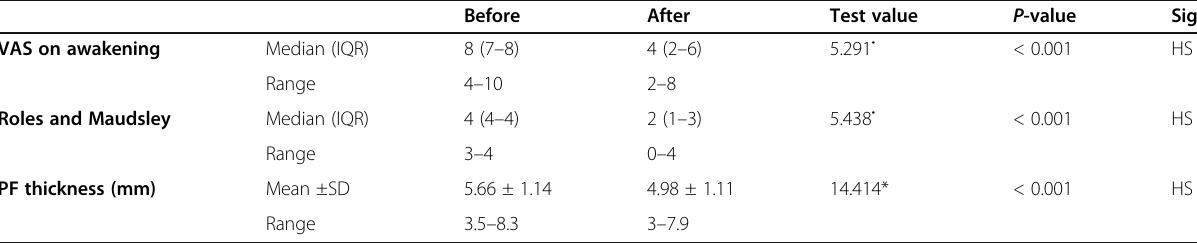
Table 3 Significance of changes in VAS, Roles and Maudsley, and PF thickness following ESWT Before After Test value P -value Sig.